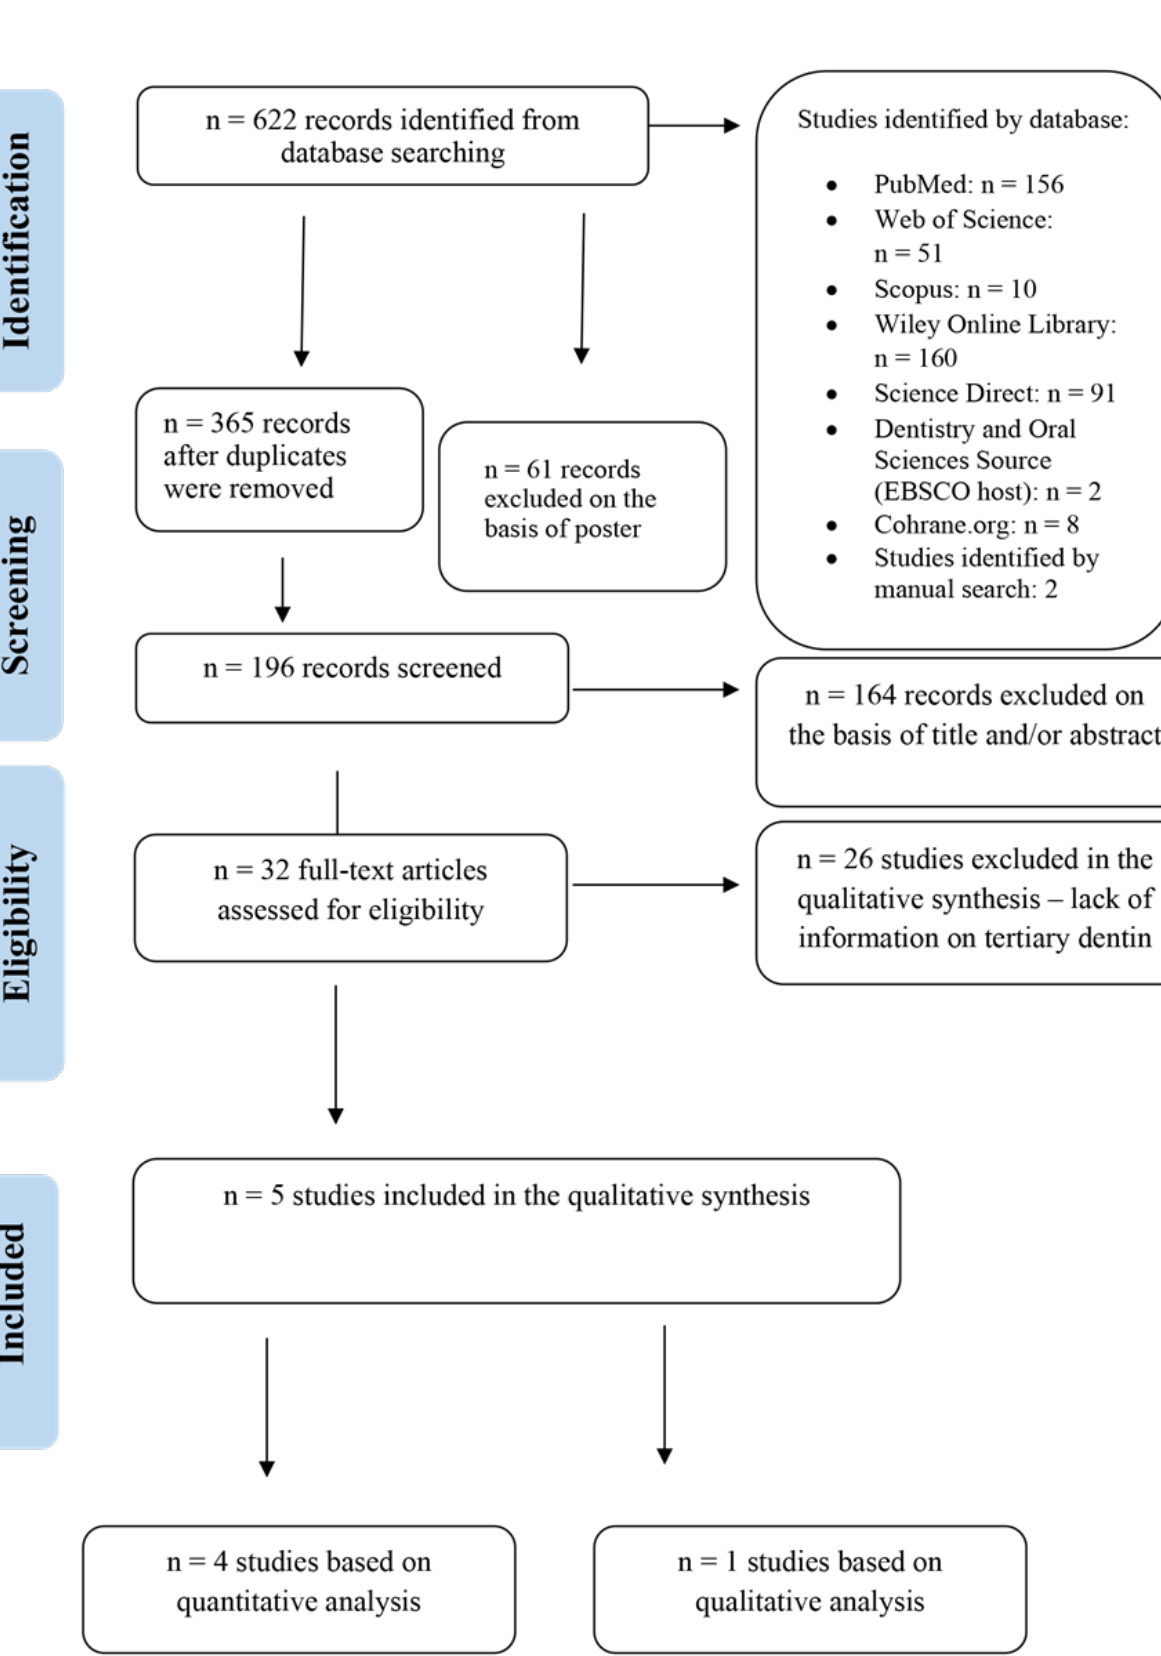
Figure 1. Preferred Reporting Items for Systematic Reviews (PRISMA) flow diagram of the search CBCT.